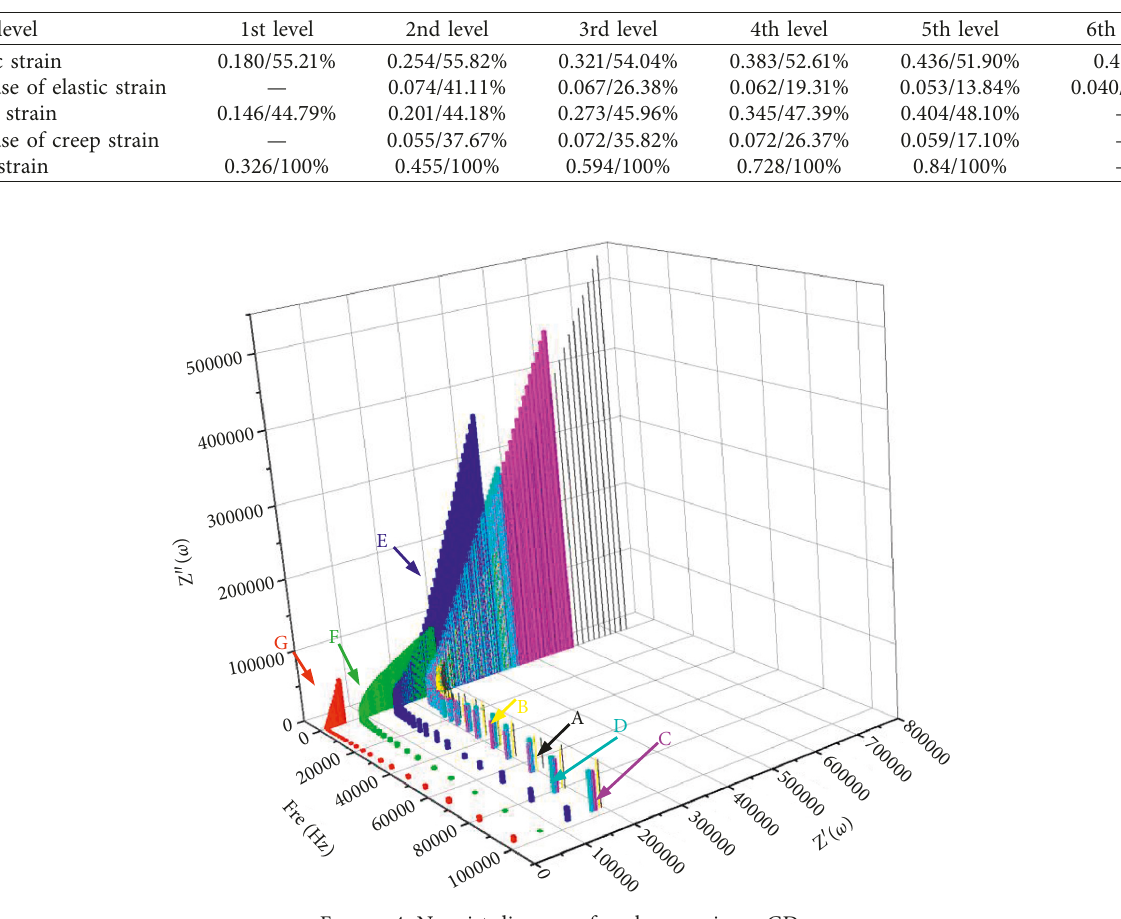
Figure 4: Nyquist diagram of anchor specimen